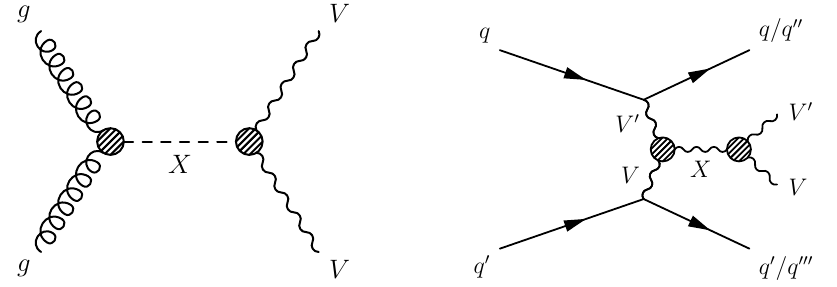
Figure 1. Feynman diagrams of the production of a high-mass particle X that decays into a diboson system; ggF ( left ) and VBF ( right ) are the two dominant